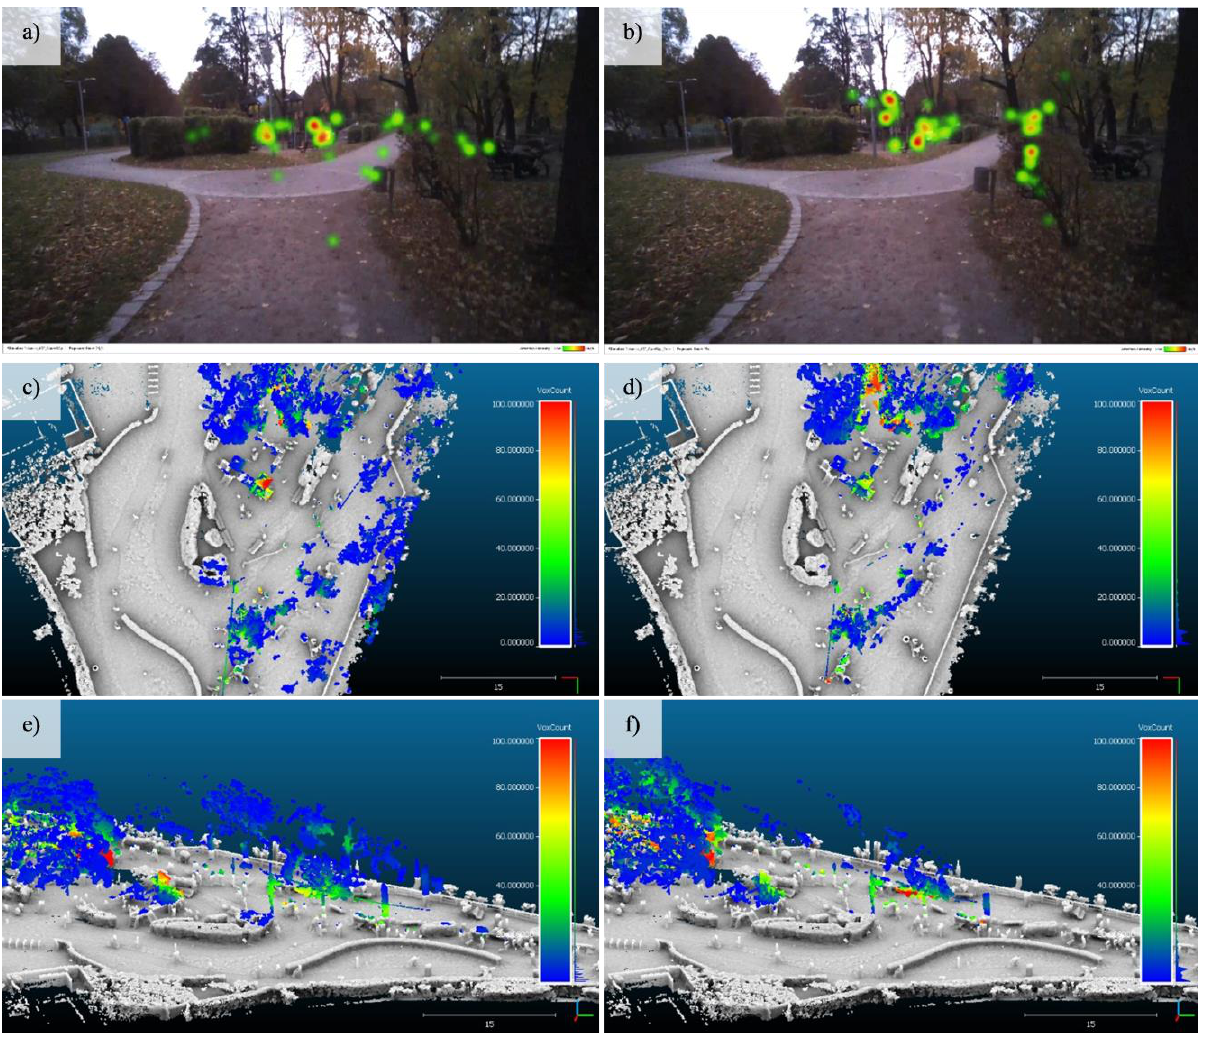
Figure 5 . 2D and 3D heatmaps for the selected participant. Subfigures in left column (a, c, e) and right column (b, d, f) are from the first and second walk, respectively. a) and b) are 2D heatmaps of the scene produced with iMotions. Red color indicates areas that have been fixated for a longer time, while yellow to green indicate medium to little attention. c), d), e) and f) are representations of our 3D heatmaps of the very same scene and eye-tracking recordings: The grey point cloud is shown for reference only; elements with a height above ground greater than 1.5 m were filtered out in order to exclude vegetation that might obscure the scene. Points that have been hit by fixations (see Section 2.7 for explanation) are shown red to blue. Again, red indicates a high number of fixations, yellow to green to blue indicate medium to few fixations. Points that have not been hit by a fixation are not shown, except for the grey background